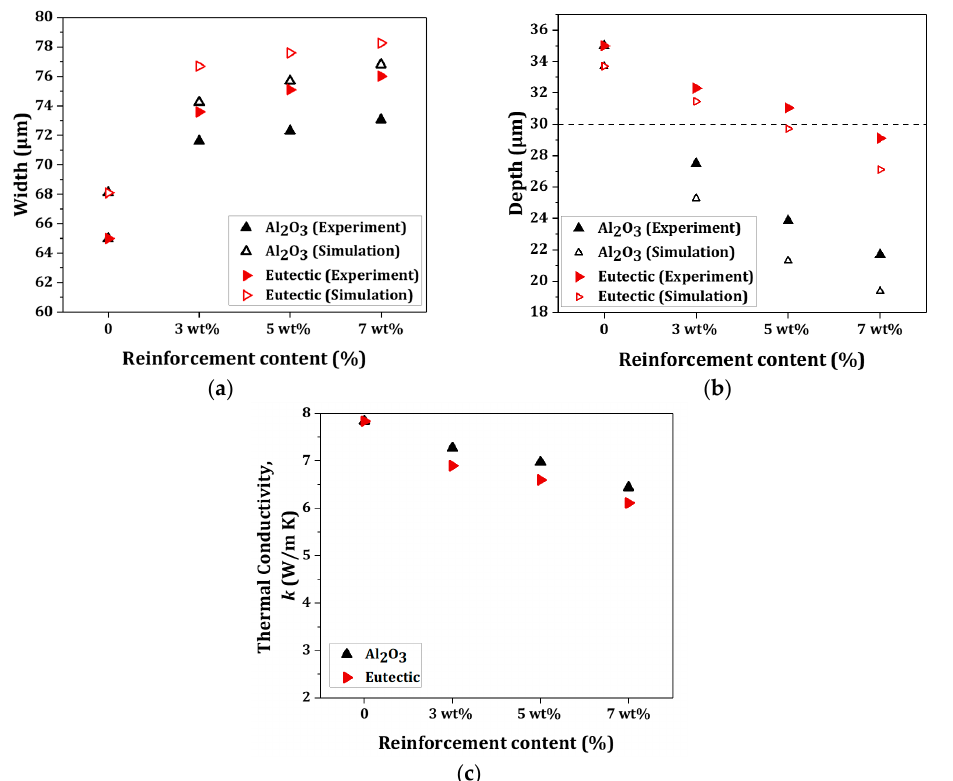
Figure 5. ( a ) Cross-section width and ( b ) depth of the experimental and numerical models. ( c ) Thermal conductivity ( k ) of the mixtures at 800 K.